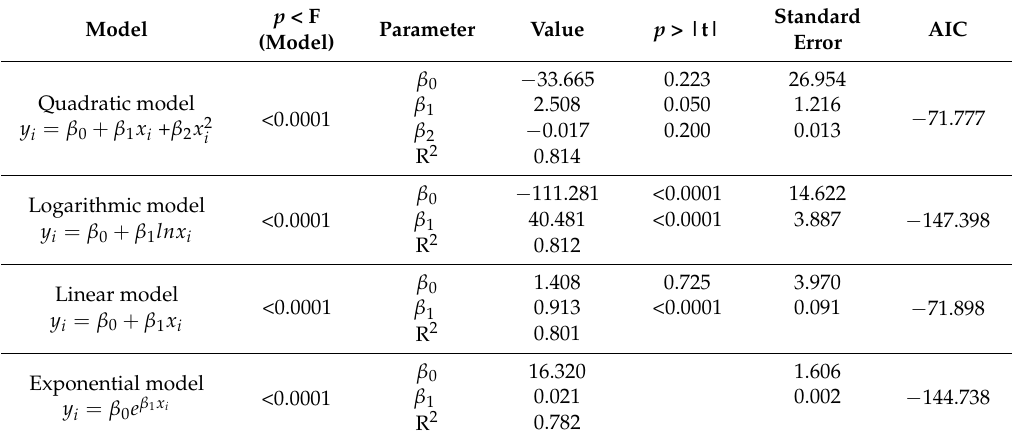
Table 13. Parameters of the regression models that were fitted for predicting the longitudinal growth of grafts as a function of the scion cambium area (CAS).